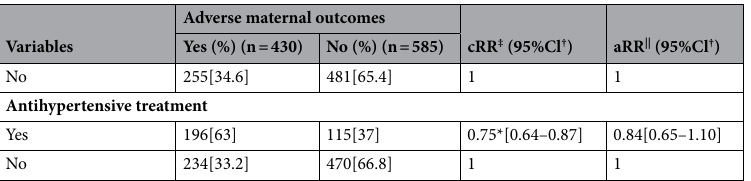
Table 4. A multivariable log-binomial logistic regression model for risk factors for adverse maternal outcomes among women with preeclampsia in Sidama region, southern Ethiopia from August 8, 2019, to October 1, 2020. † CI = Confidence interval. ‡ cRR = Crude relative risk. †† SVD = Spontaneous vaginal delivery.